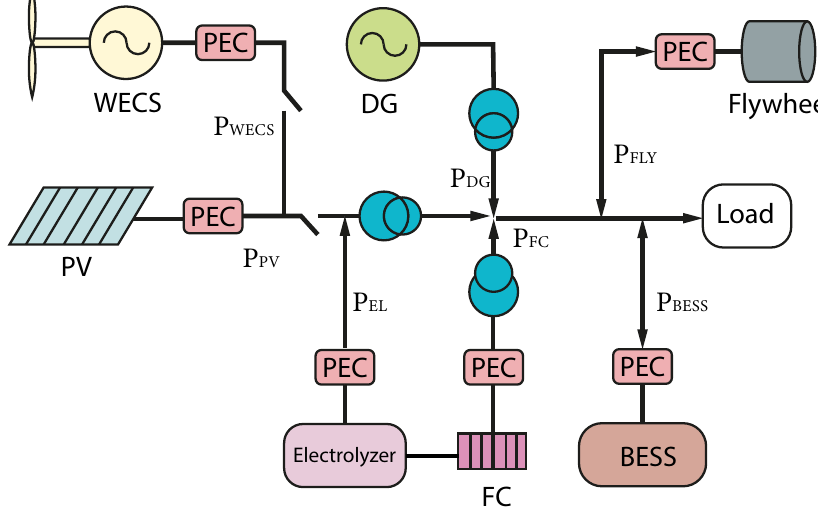
Figure 7. Hybrid MG with different electrical